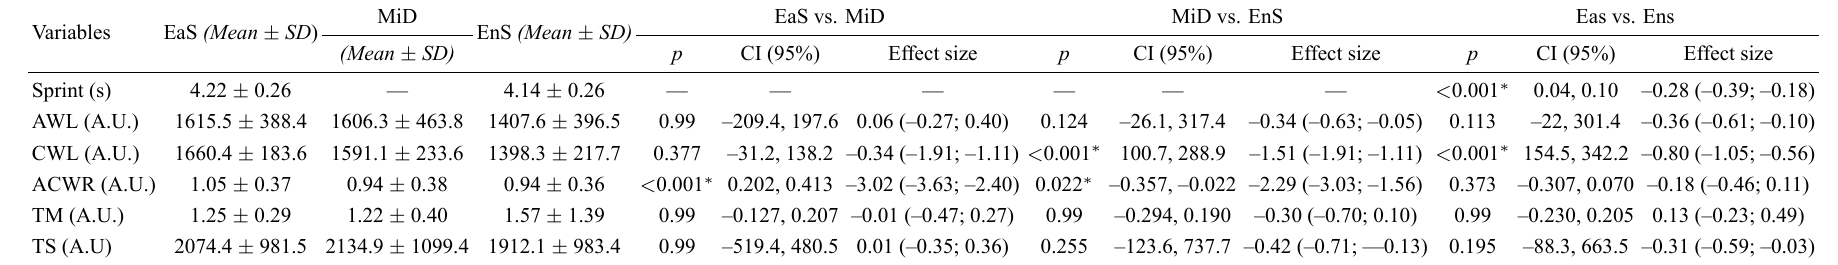
Table 2. Comparison of different time point in the workload parameters and sprint test.